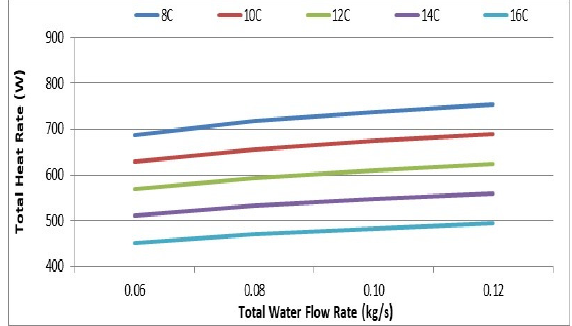
Fig. 12. The total heat rate of terminal units at 8, 10, 12, 14 and 16 °C water supply temperature and valve opening: Valve 1=100%, Valve 2=100% and Valve 3=75%.